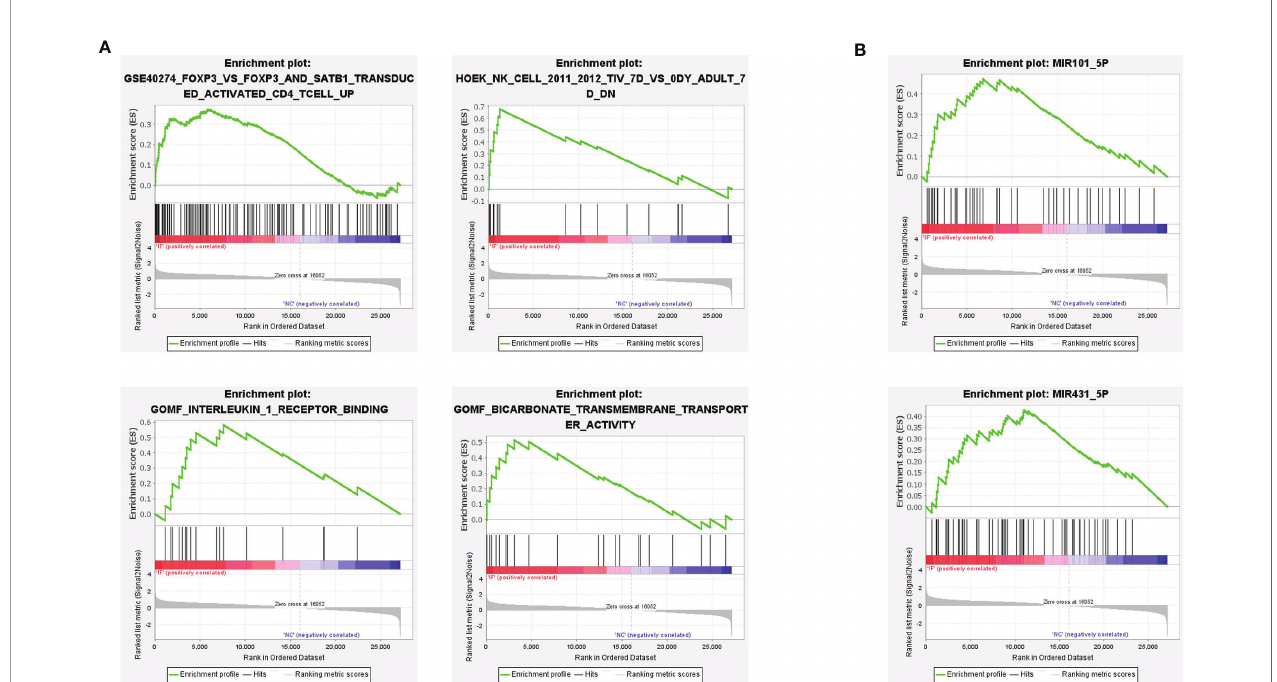
FIGURE 3 | Gene set enrichment analysis (GSEA) revealed the in fl ammatory signatures in CE. (A) The immune features of gene sets were enriched in CE. P < 0.05. (B) The miRNA regulation pathway of gene sets was enriched in CE. P <